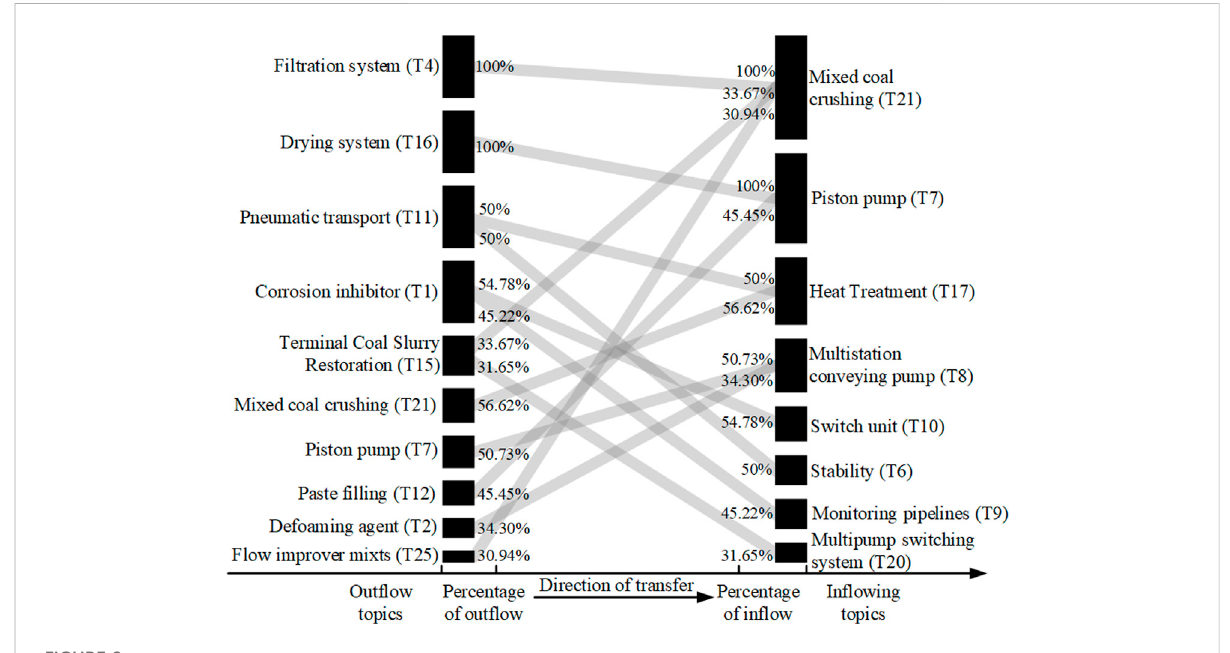
FIGURE 2 The transfer process between technology topics.